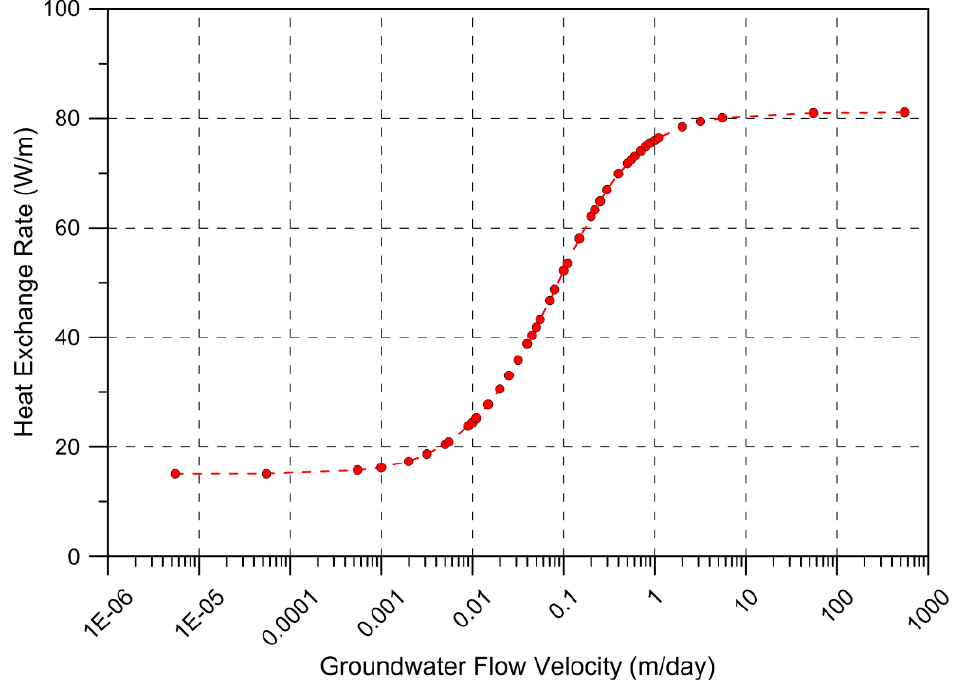
Figure 6. Relationship between groundwater flow velocity and heat exchange rate in the uniform model. Table 2. Relationship between arithmetic average groundwater flow velocity and parameters (cid:2009) and (cid:2010) .